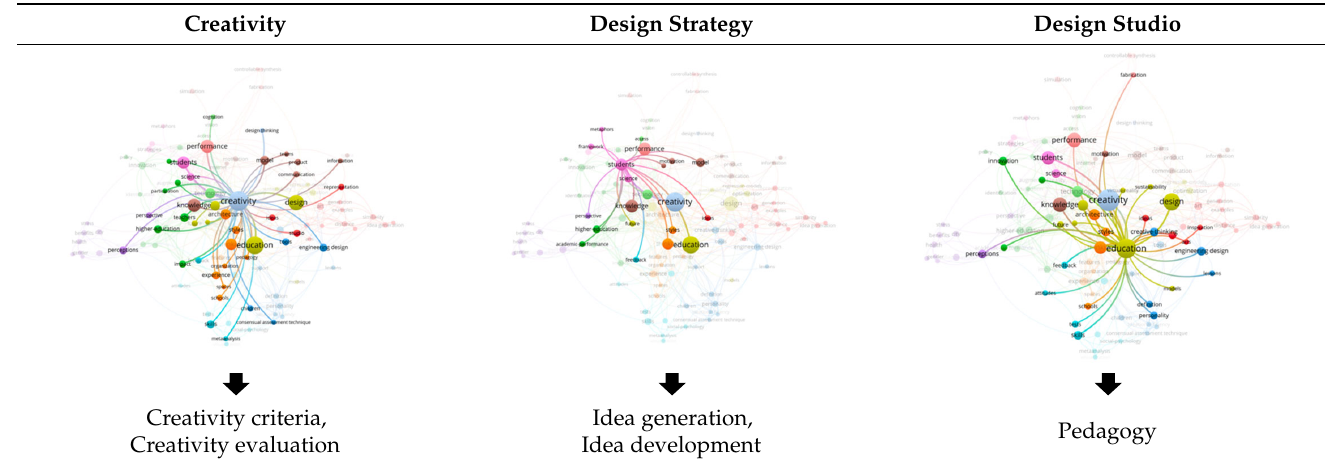
Table 4. Defining aspects of creativity, design strategy, and design studio.